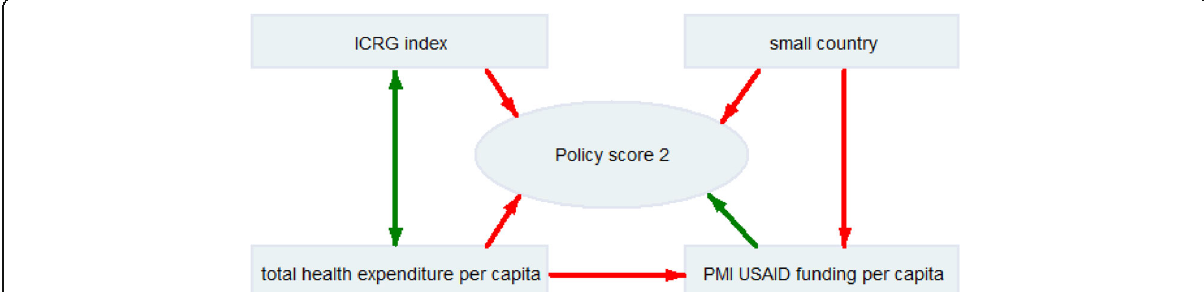
Fig. 3 Relationships of policy score 2 and economic, institutional and environmental parameters. * green line indicates a positive correlation, red line indicates a negative correlation with policy score 2. ICRG: the international country risk guide; PMI: United States President ’ s Malaria Initiative; USAID: United States Agency for International